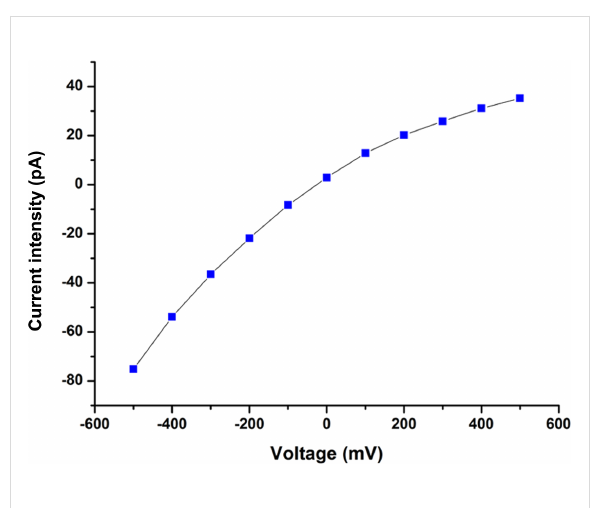
Figure 3: I ( V ) at [KCl] = 10 − 4 mol·L − 1 for a capillary with r tip =13 nm, θ = 9° and l tip = 15 mm. The current intensity as a function of the voltage was extracted from the result in Figure 2 and exhibits a rectifi- cation effect: ICR 500 = I − 500mV / I +500mV = 1.53 at [KCl] = 10 − 4 mol·L − 1